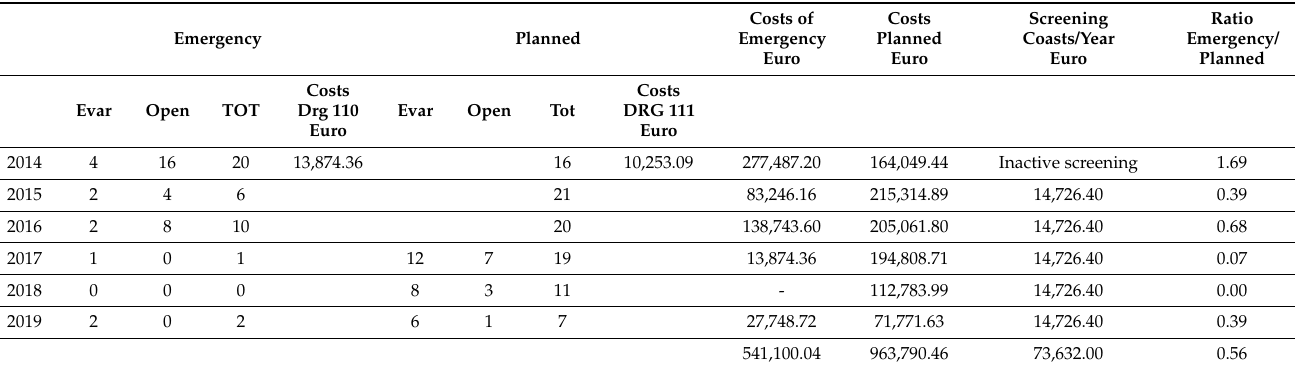
Table 4. Screening according to surgery and